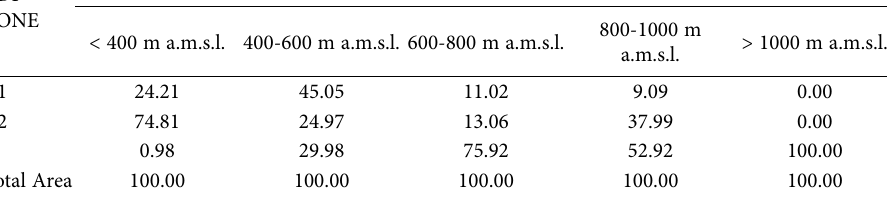
Source: own elaboration on Digital Terrain Model of Tuscany Region and RDP regional